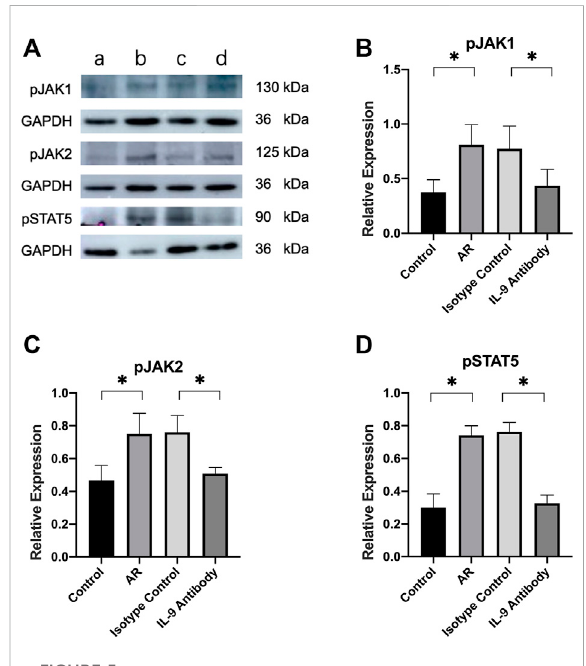
FIGURE 5 Expression of JAK1/2 and STAT5 in mucosa. (A) Western blot analysis for p-JAK1/2 and p-STAT5 in nasal mucosa. Each lane contains 30 μ g of protein. The relative expression of the protein was based on GAPDH. a was the control group, b was the allergicrhinitisgroup,cwasIL-9neutralizingantibodygroupandd was the homotypic control group. Each lane is a representation of fi ve independent experiment samples. (B) – (D) Western blot was analyzed quantitatively by ImageJ software. We used target/ GAPDH to obtain therelativeexpressionof thetargetprotein.